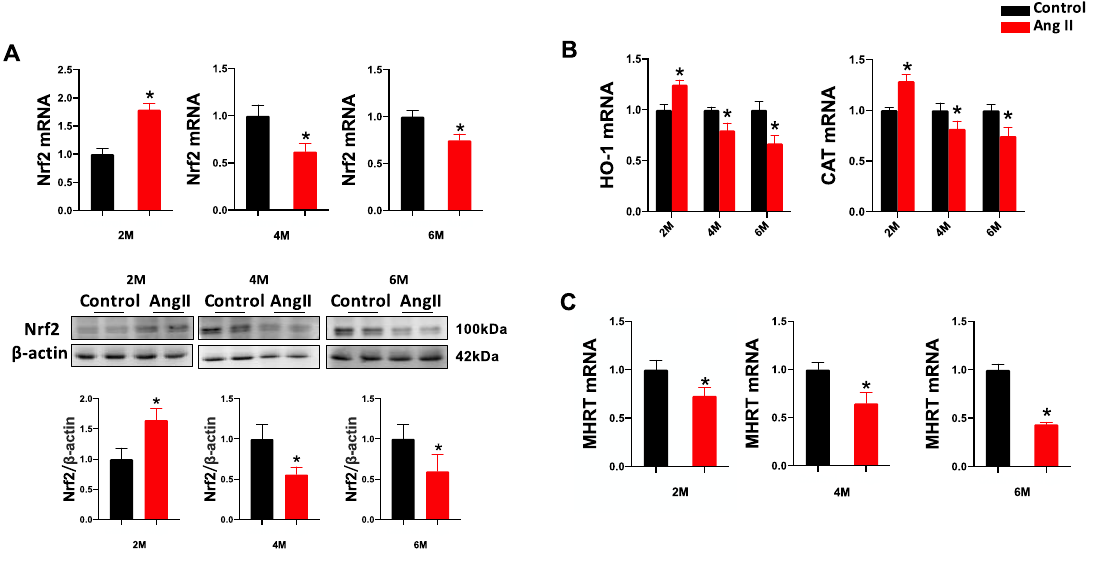
Figure 3. Ang II treatment affects the expression of Nrf2 and the transcription of HO-1, CAT and MHRT. The expression of Nrf2 was examined by qPCR and western blot ( A ). The mRNA expression of HO-1, CAT ( B ) and MHRT ( C ) was analyzed by qPCR in the heart of mice with or without Ang II treatment. Data are presented as the mean ± SD ( n = 7–9). * p < 0.05 vs.